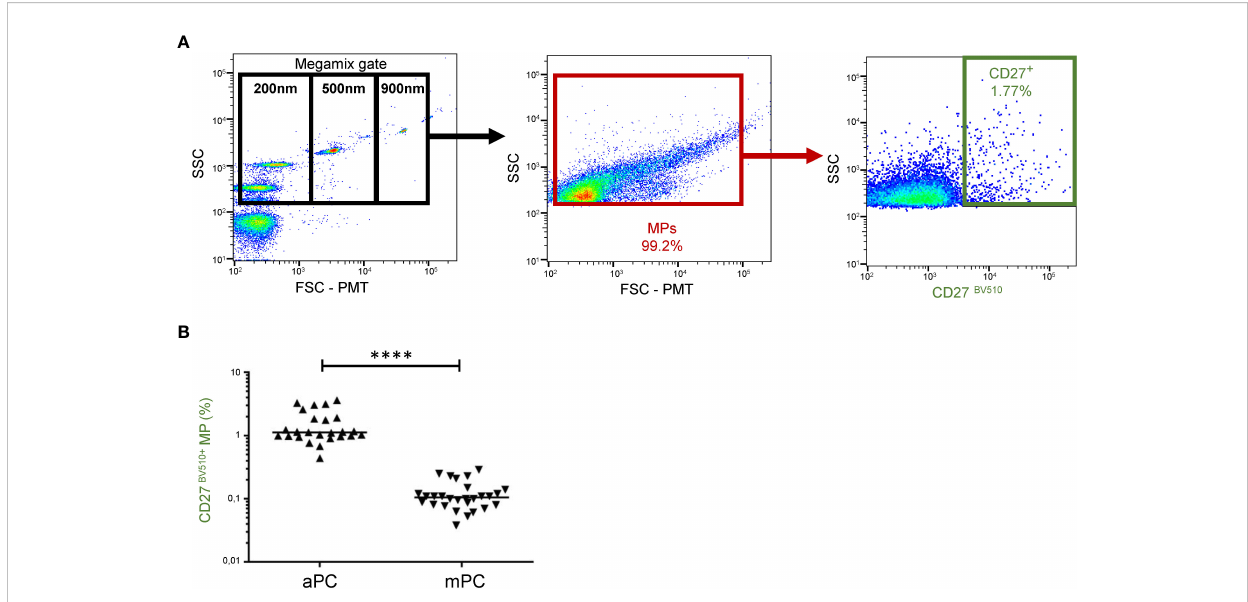
FIGURE 1 CD27 expression on MPs from platelet concentrates. (A) Example of the gating strategy used in the phenotyping of MPs from HDs. On the left, a dot plot showing the settings, based on Megamix fl uorescent beads, for the differentiation of three particle sizes: 200, 500 and 900 nm in diameter. (B) CD27 phenotyping was performed with a anti-CD27-BV510 antibody on apheresis platelet concentrates (aPCs) from 25 HDs in two experiments and on mixed platelet concentrate (mPCs) pools for 28 HDs in two experiments. The horizontal bar indicates the median value. The P values were obtained in Mann-Whitney post hoc tests: **** P <